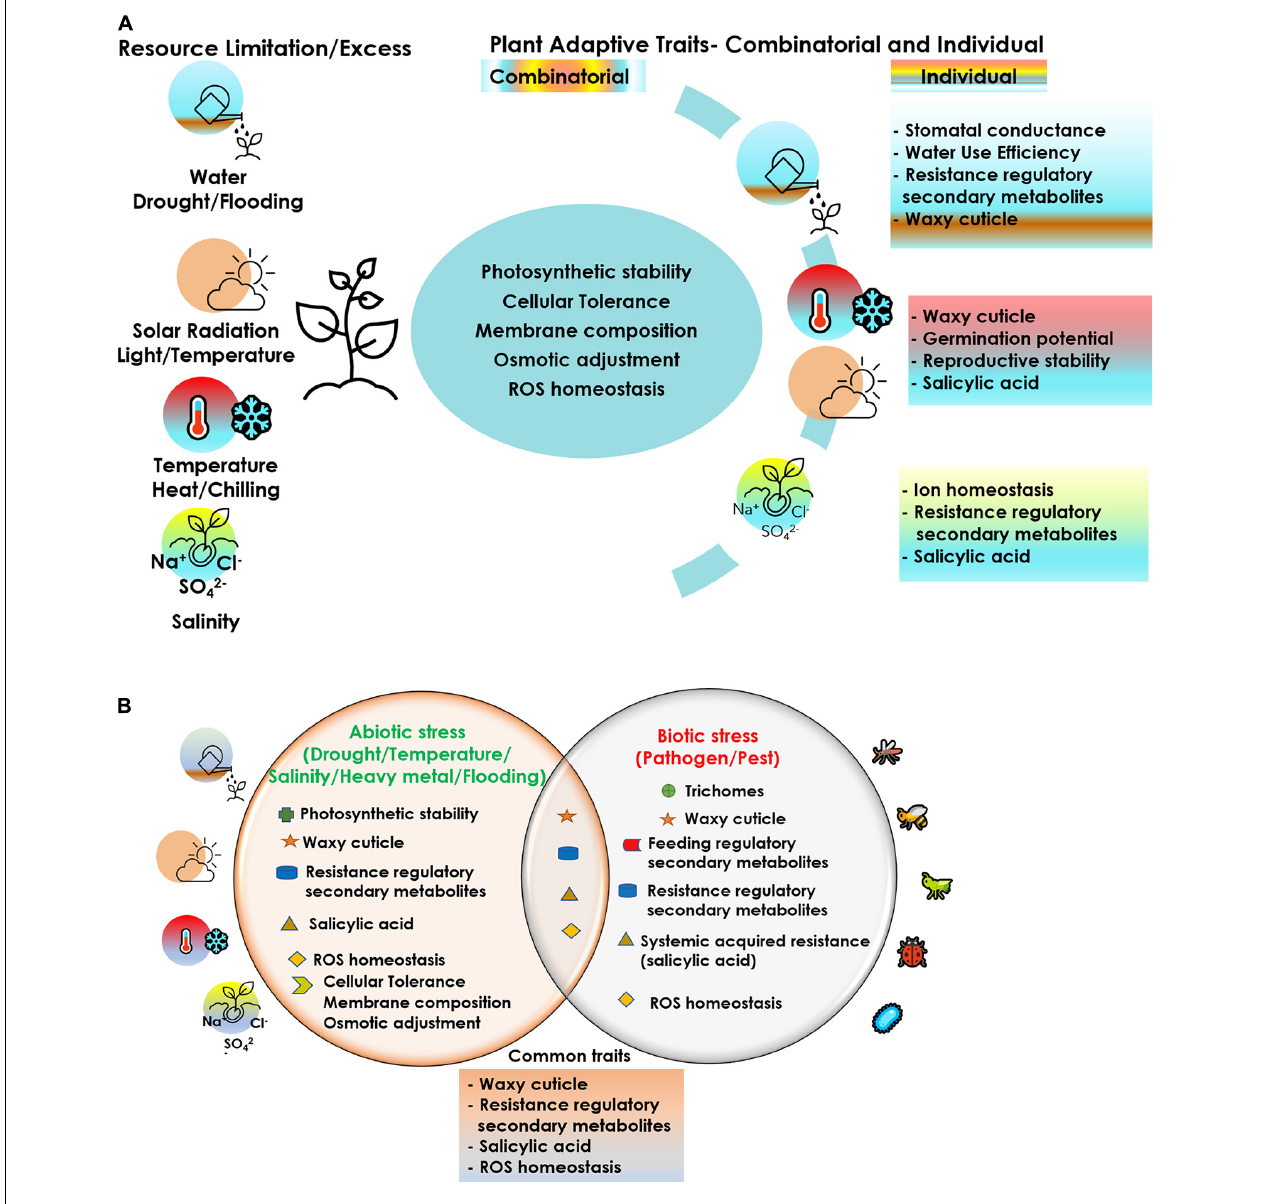
FIGURE 2 | Plant adaptive traits/mechanisms critical under each stressor and prospective trait-stress combinations under co-occurrence of different stresses in cucurbits; (A) abiotic–abiotic, (B) abiotic–biotic.